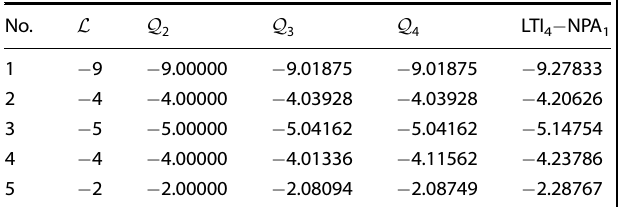
Table 4. Ground state energy density for fi ve 232-type TI Hamiltonians with different local observable